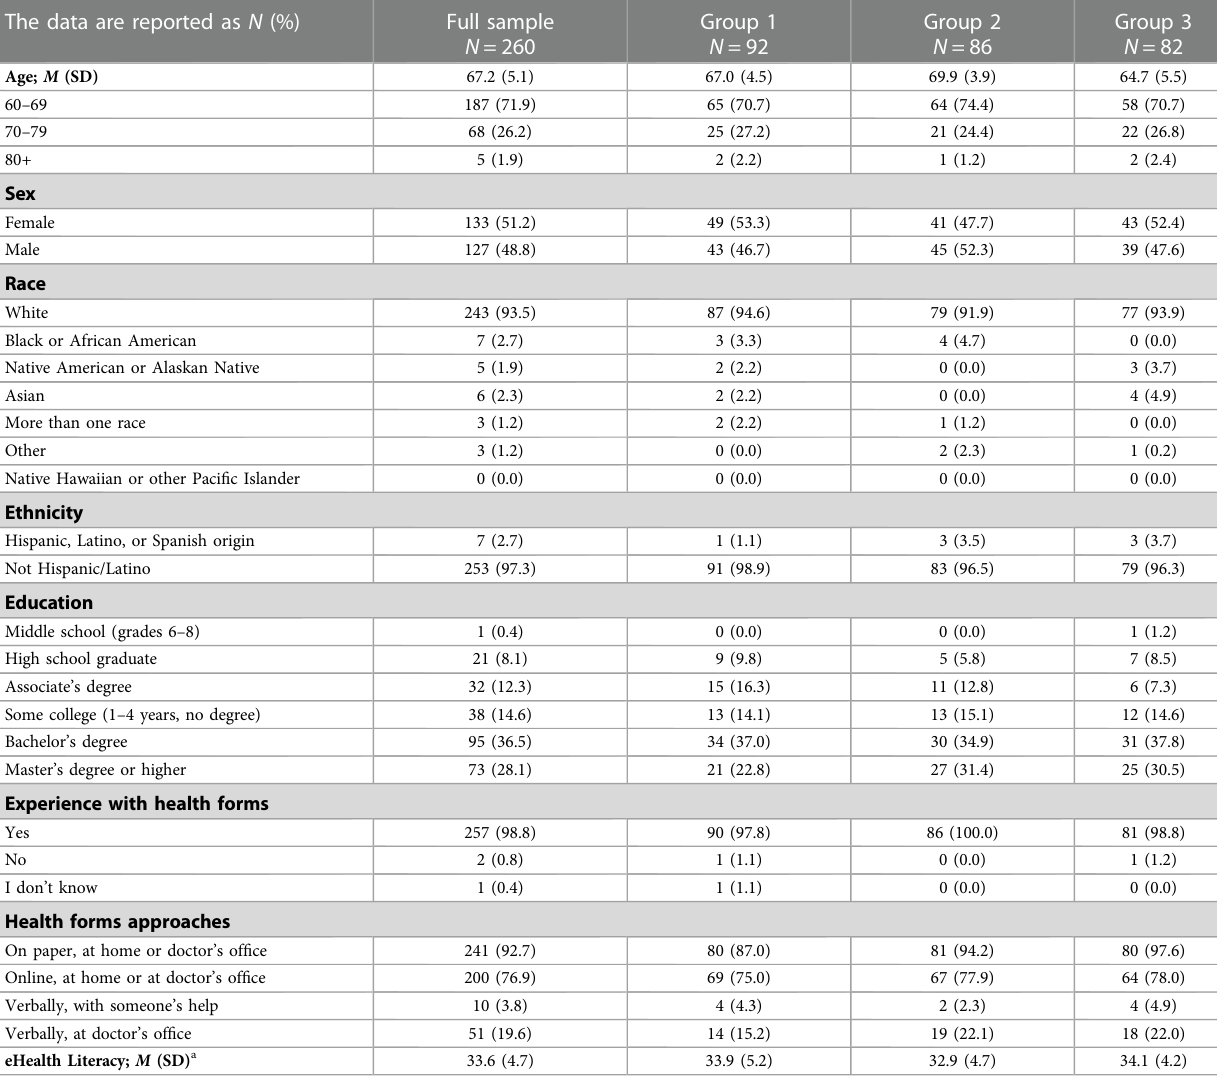
TABLE 3 Participant demographics and experience with health forms questions. The data are reported as N